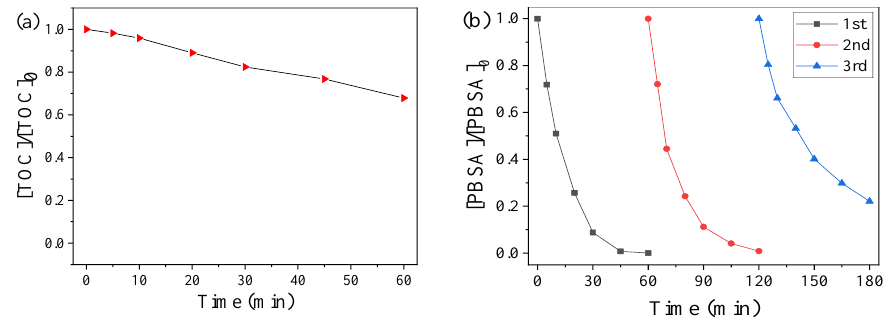
Figure 6. Total organic carbon (TOC) removal of the PBSA oxidized by the CoMn 2 O 4 -activated PMS system ( a ); Degradation of the PBSA using the recycled catalyst ( b ). Conditions: [PBSA] = 5 mg L − 1 ; [catalyst] = 50 mg L − 1 ; [PMS] = 250 mg L − 1 ; T = 25 ◦ C; and without pH